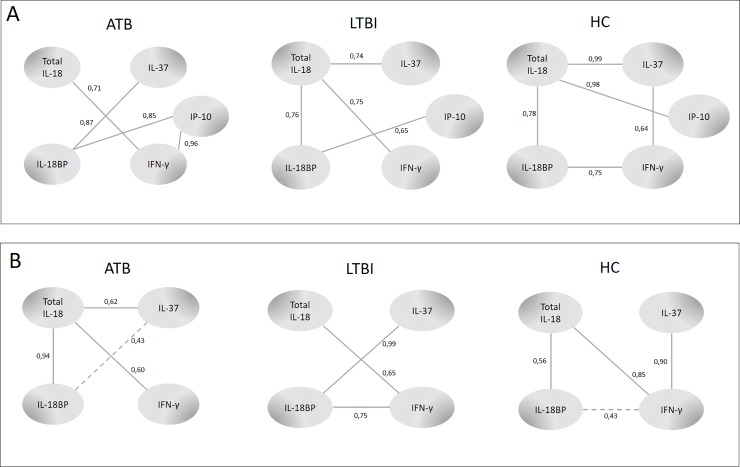
Network patterns among studied proteins measured in serum (A) and QFT supernatants (B) from pulmonary TB patients (ATB), latently infected subjects (LTBI) and non-infected healthy controls (HC) The numbers, all between 0 and 1, correspond to the 'likelihood' of observing a given co-expression in a network generated from a random subset of (at least 80% of) individuals in the group of interest.